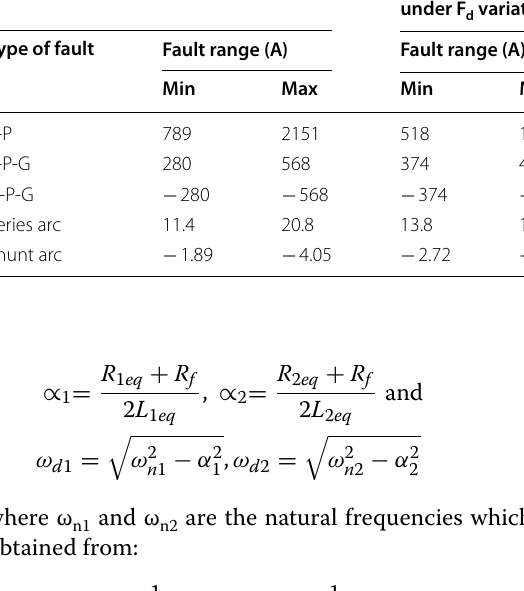
under F d variation